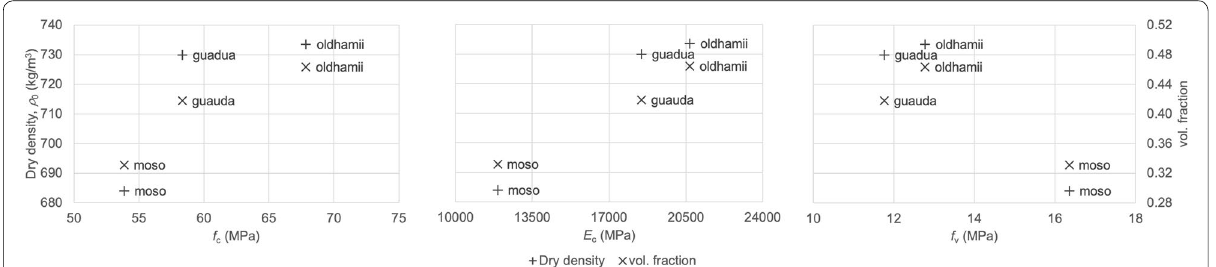
Fig. 11 Correlation between mean values of mechanical properties and density and volume fraction